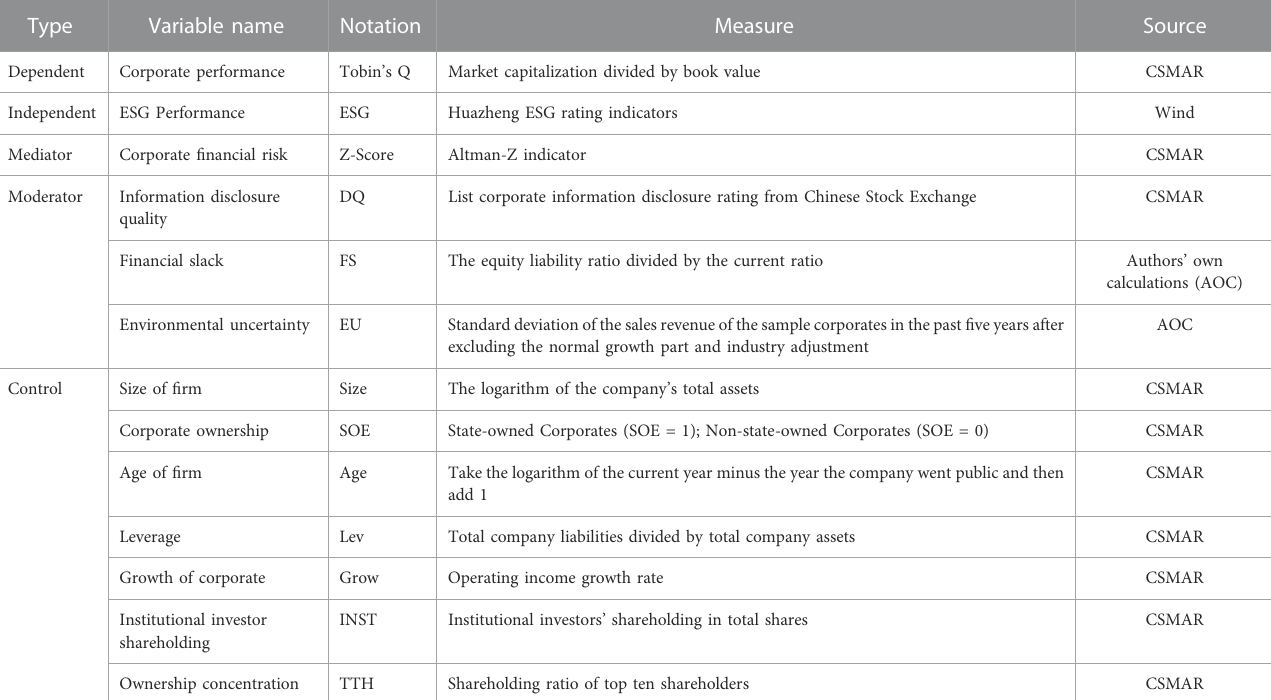
TABLE 1 De fi nition of